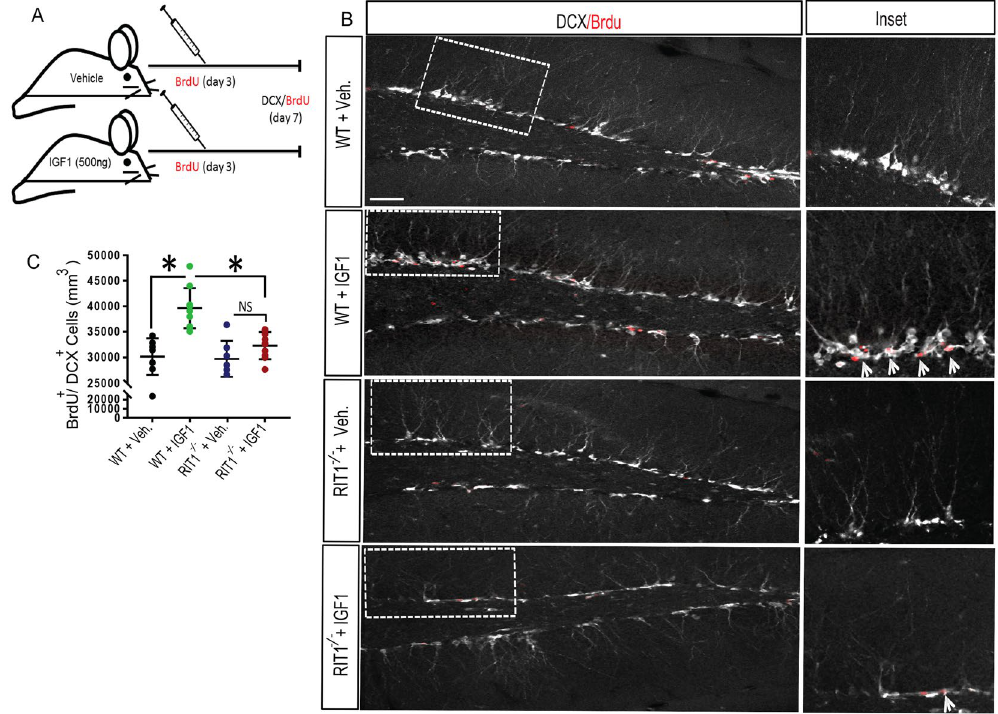
Figure 3. RIT1 deficiency impairs IGF-1-dependent adult neurogenesis. ( A ) WT and RIT1 − / − mice (n = 10 per genotype) were continuously administered either rhIGF-1 (500 ng/kg/day) or vehicle via subcutaneous pump infusion for 1 week. At day 3 of infusion, mice were i.p. injected with BrdU (50 mg/kg) ( × 4) over 12 h. ( B ) Representative coronal hippocampal sections co-immunostained for BrdU ( red ) and DCX ( white ) (Scale bar 20 μ m). The inserts are at higher magnification. Arrowheads ( white ) indicate newborn DCX + /BrdU + neuroblasts. ( C ) Quantification of the BrdU + /DCX + proliferating neuroblast density (cell counts/mm 3 ) within the dentate gyrus of WT and RIT1 − / − mice ( * p < 0.01, one-way ANOVA). Results are presented as mean ±